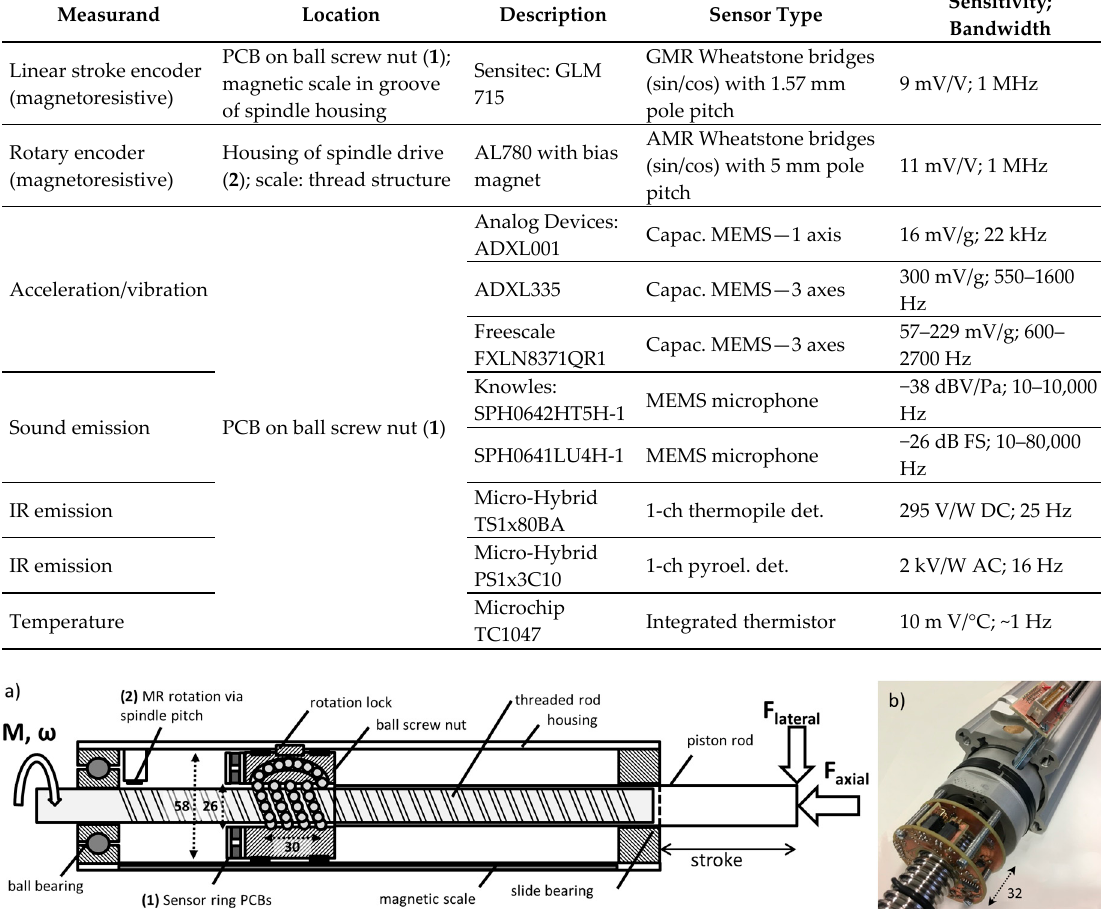
Figure 1. ( a ) Mechanical integration of the sensor system inside the EMC and ( b ) realization of the stacked sensor ring PCBs with spindle shaft inside in a disassembled